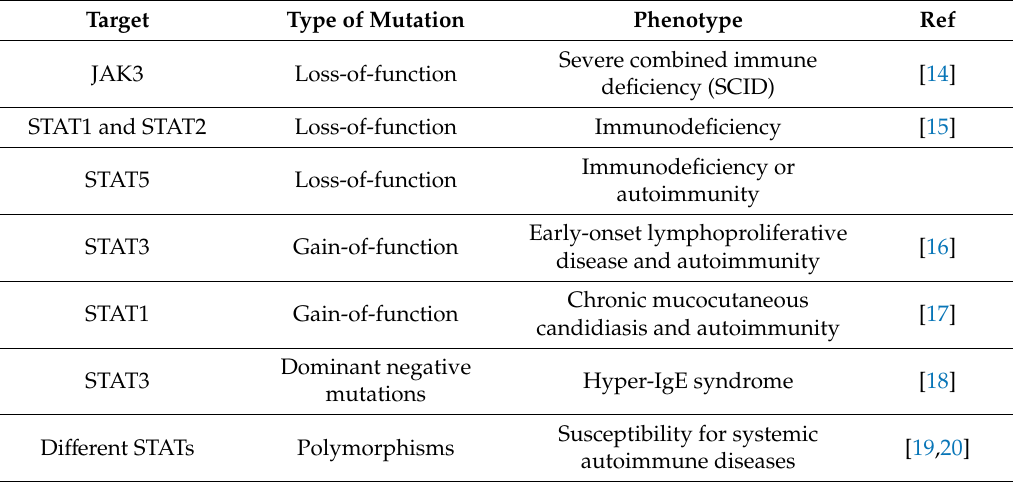
Table 2. Mutations of JAKs and STATs leading to a pathologic phenotype.